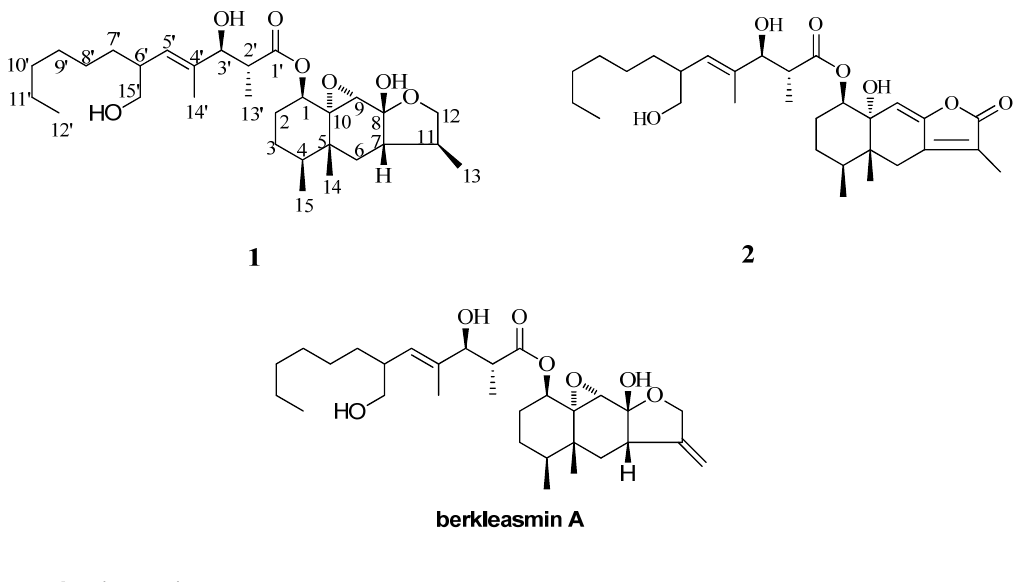
Figure 1. The structures of compounds 1 , 2 and berkleasmin